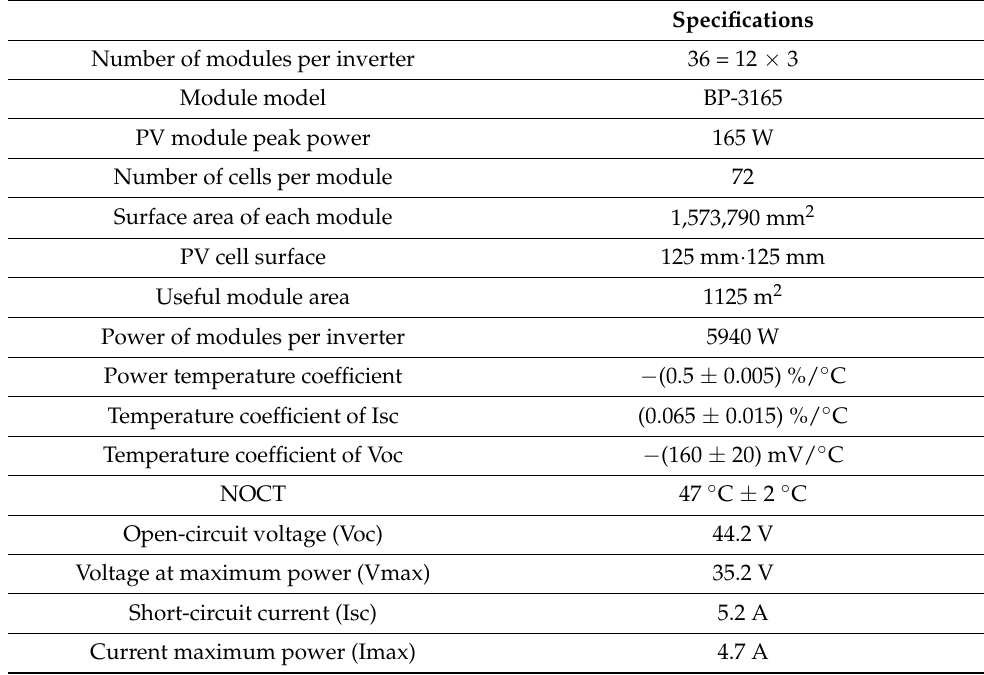
Table 1. General characteristics of the installation and its PV